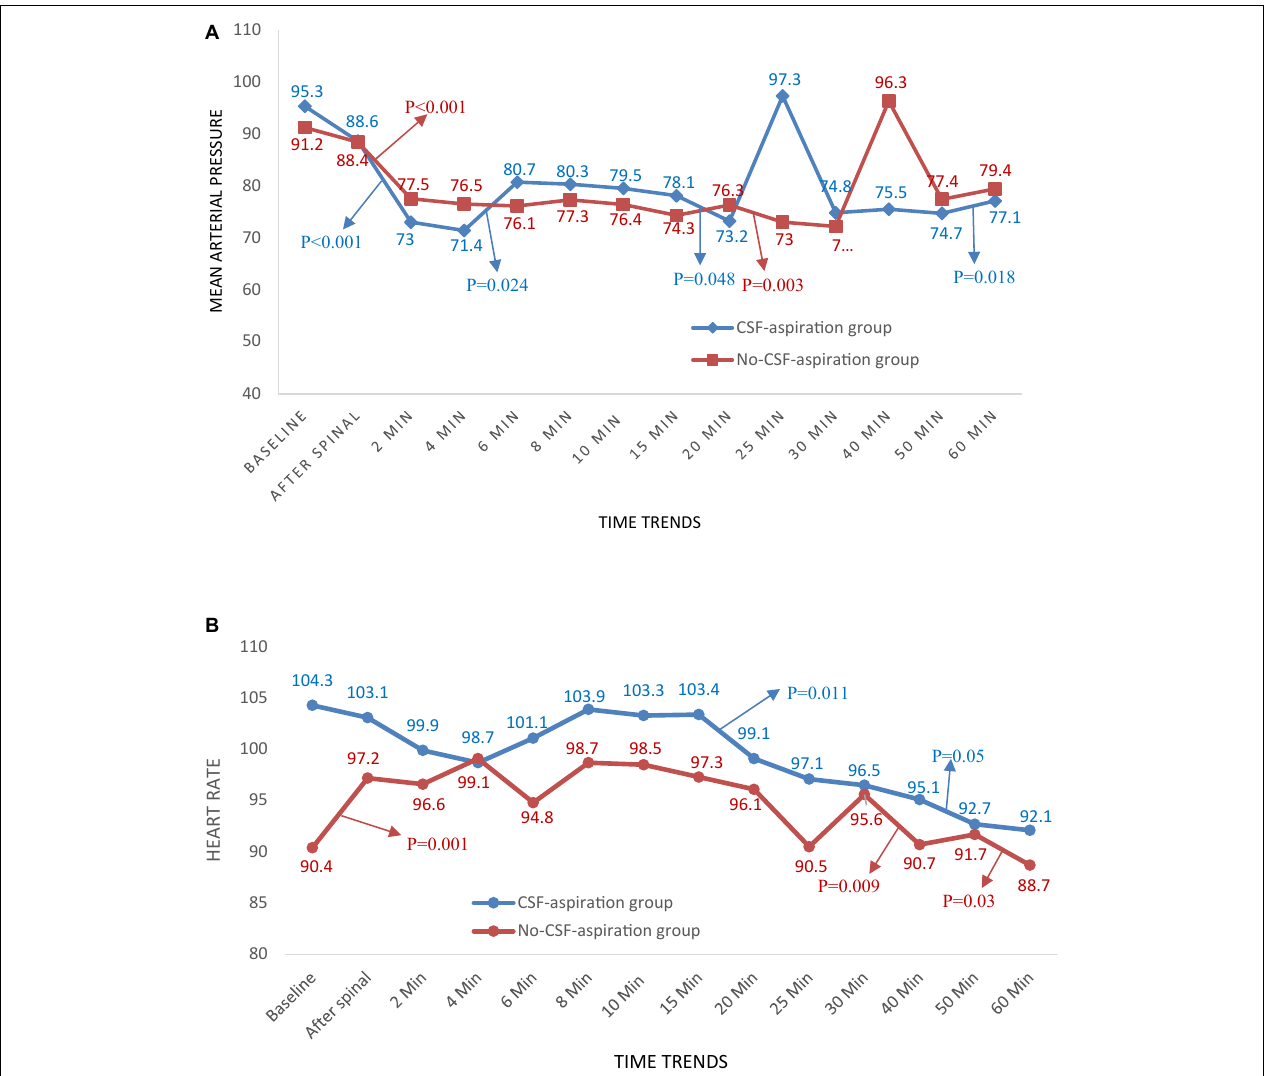
FIGURE 3 | Changes (A) main arterial pressure and (B) heart rate in two groups of study over times, * P -values shows statistically significant between two times within groups.